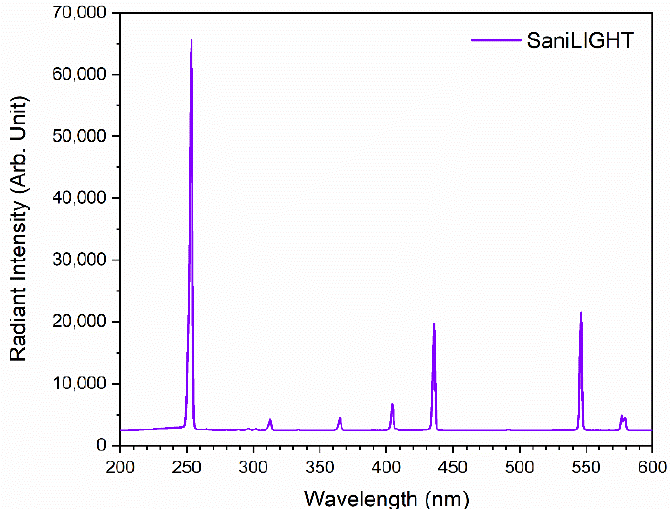
Figure 2. The emission spectrum of the light source used (SaniLIGHT®).